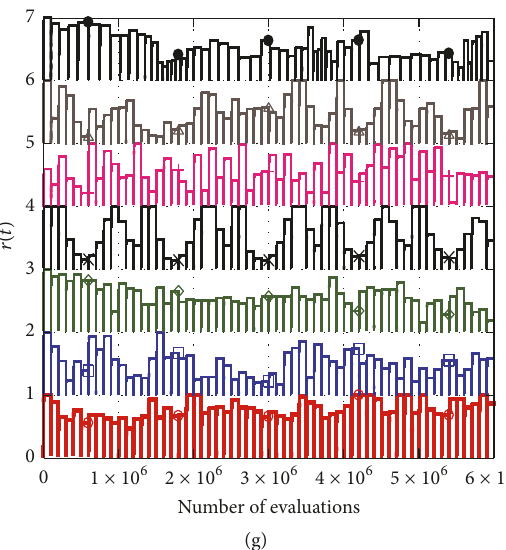
Figure 1: Convergence graph of PLBA for (a) 𝐹 1 ( 𝑚 = 10 ), (b) 𝐹 1 ( 𝑚 = 50 ), (c) 𝐹 2 , (d) 𝐹 3 , (e) 𝐹 4 , (f) 𝐹 5 , and (g) 𝐹 6 where relative values ( 𝑟(𝑡) ) are presented for each 𝑇 𝑖 as 𝑟(𝑡) + 𝑖 − 1 , where 0 ≤ 𝑟(𝑡) ≤ 1 and 𝑖 = 1, 2,. .. ,7 .